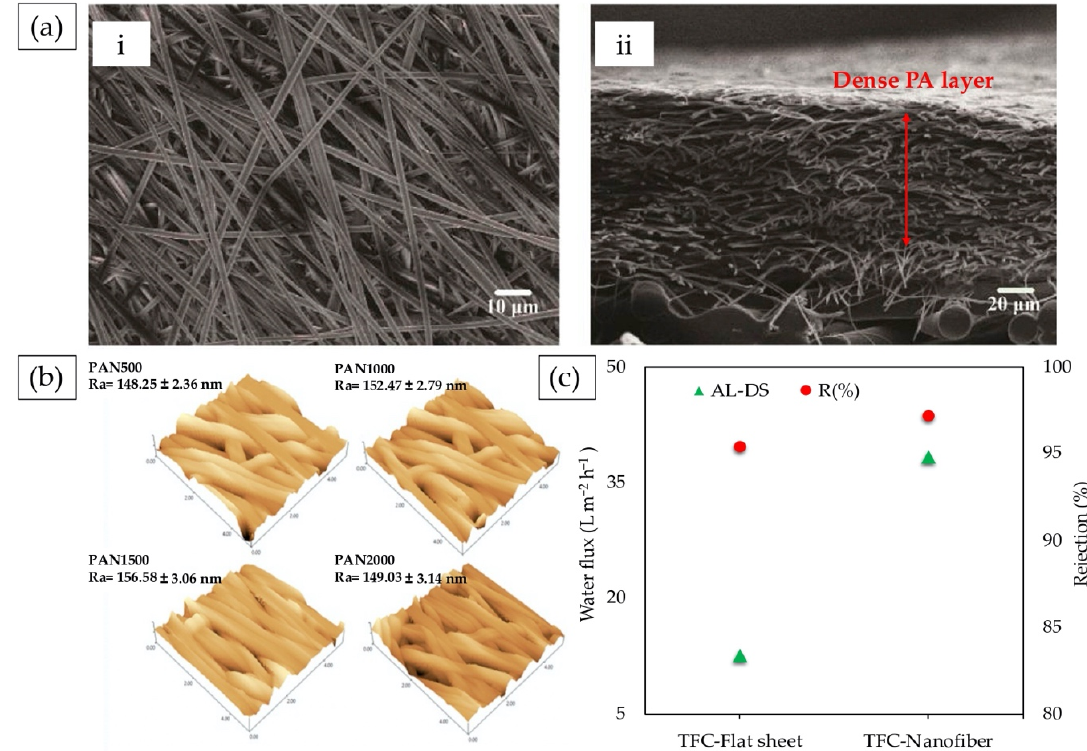
Figure 4 ( a ) SEM images of the polysulfone (PSf) nanofiber substrate (i) top surface and (ii) cross-